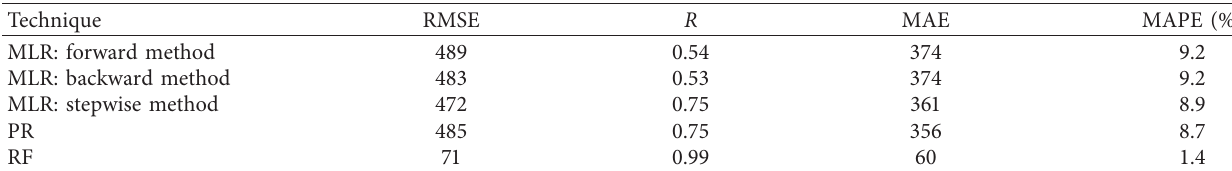
Table 6: Performance of the regression models.